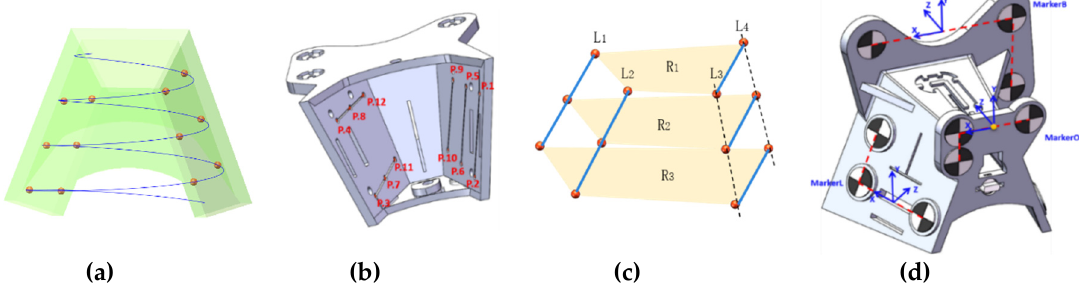
Figure 8. Design of online C-arm calibrator: ( a ) design model of calibrator; ( b ) distribution of 12 fiducial points; ( c ) projection model of fiducial points; ( d ) distribution of visual markers.